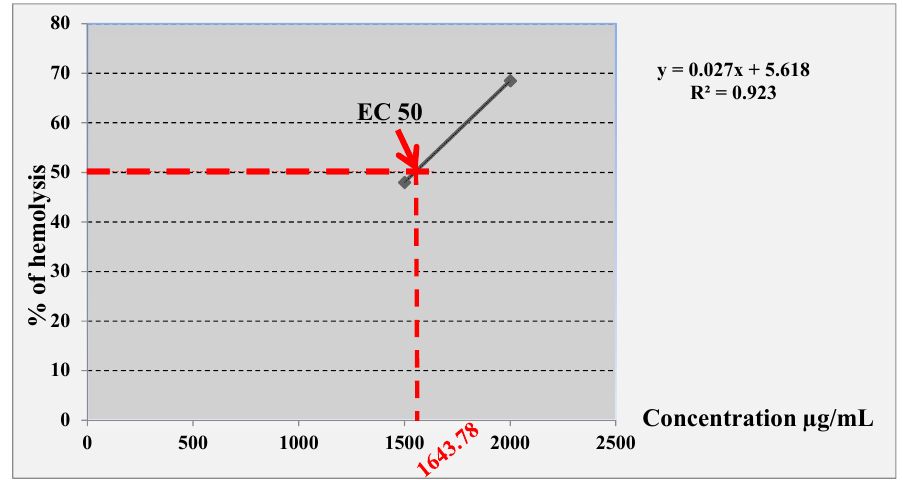
Figure 5. Linear equation of the curve to determine the EC50 of A. gombiformis butanolic extract.